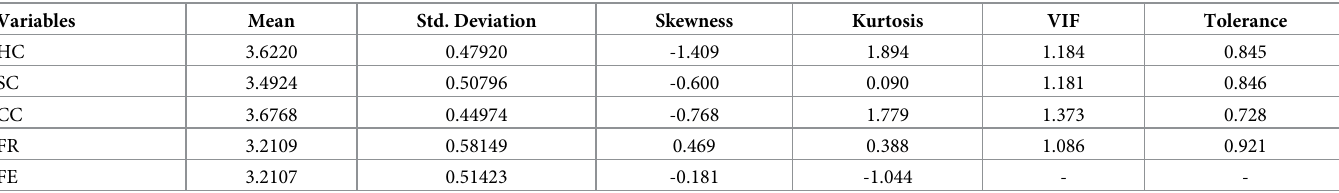
Table 2. Descriptive